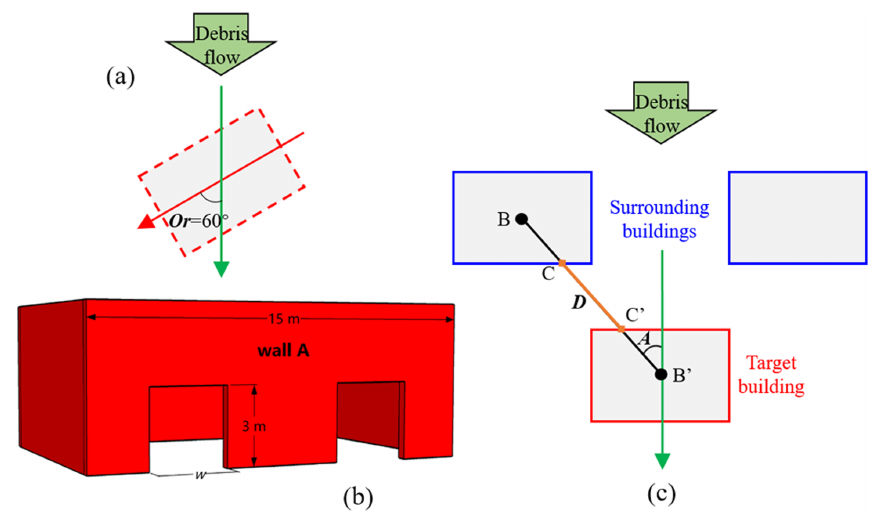
Figure 4. The schematic drawings of the target building and surrounding buildings: (a) orientation of target building (Or), (b) opening scale of the target building (Op), and (c) azimuth angle ( A ) and distance ( D ) of surrounding building with respect to the target building.